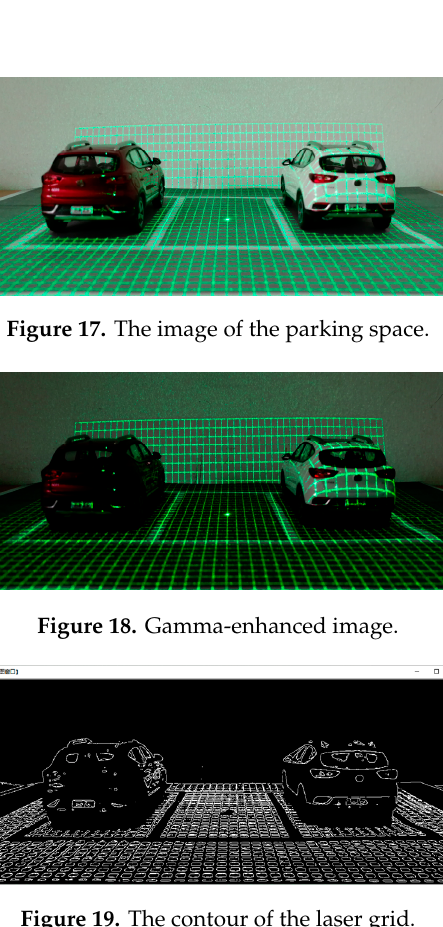
Figure 19. The contour of the laser grid.